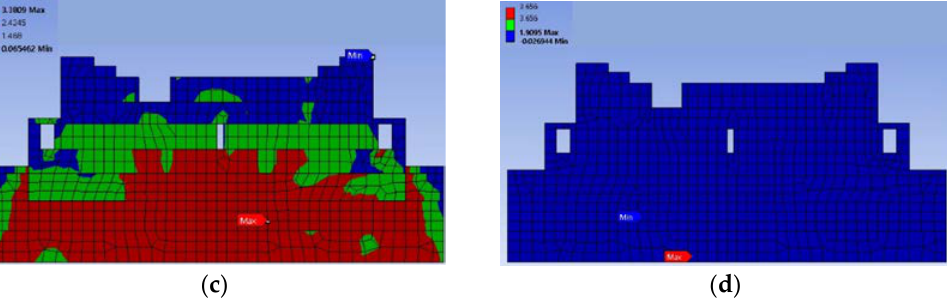
Figure 4. Stress subjected to the dead and seismic loads: ( a ) Shear stress of the 4th Floor slab; ( b ) bending stress of 4th Floor cracked in flexure; ( c ) Shear stress of an H2 direction wall; ( d ) bending stress of an H2 direction wall.